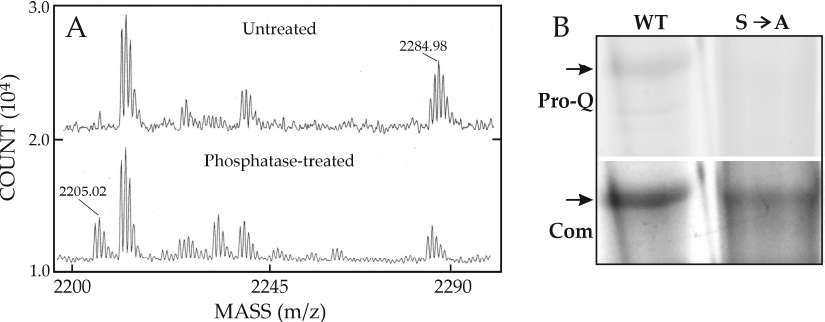
Figure 6. Ser 2497 is phosphorylated in the HARE CD. ( A ) Immunopurified WT HARE cut from an SDS-PAGE gel was trypsin digested and samples were untreated (top) or treated with alkaline phosphatase (bottom). Mass spectrometry analyses using a Voyager Elite MALDI-TOF instrument in reflector mode revealed signals at m / z 2284.98 for a phospho-(Thr 2389 -R 2508 ) peptide, which was reduced by phosphatase treatment, resulting in strong signals for the predicted free peptide ( m / z 2205.02). ( B ) HARE was immunopurified from stable Flp-in 293 cells expressing WT (left) or S2497A (right) HARE, run on SDS-PAGE, electroblotted, stained with Pro-Q for phosphoryl groups [57,58] and HARE (arrows) was visualized by fluorescence microscopy (top) and then, after washing and staining, with Coomassie blue (bottom).